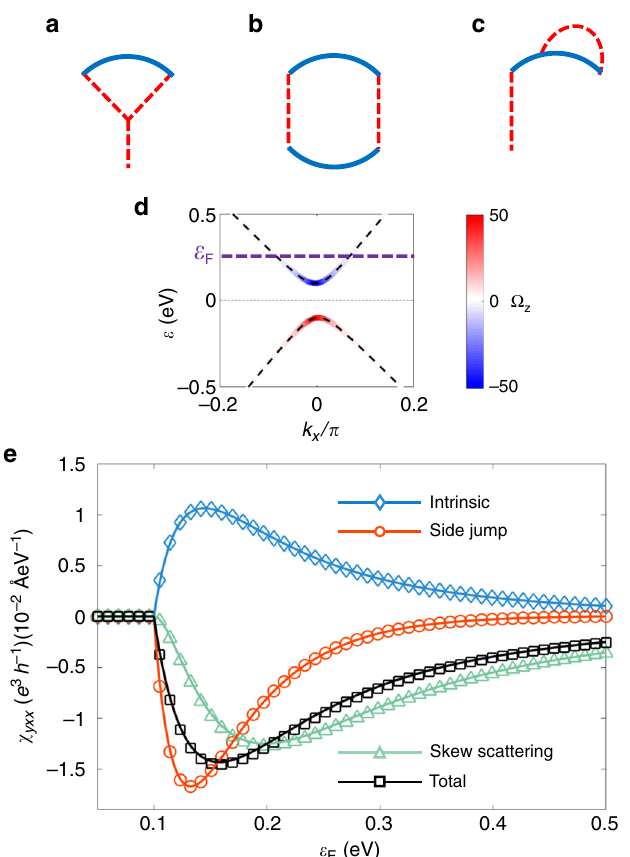
Fig. 2 Nonlinear Hall response of 2D tilted massive Dirac model. Terms contributing to the antisymmetric part of the scattering rate ϖ ð 3 Þ ϖ ð 4 Þ ( b , c ). d The band structure with the intensity plot of the Berry ll ′ curvature Ω z . e The intrinsic, side-jump, skew-scattering, and total contributions to nonlinear Hall conductivity χ Dirac model at zero temperature with a constant relaxation time τ . The markers are the numerical results and the solid lin es are analytic results up to leading t . Parameters are chosen as t ¼ 0 : 1 eV (cid:6) Å, v ¼ 1 eV (cid:6)